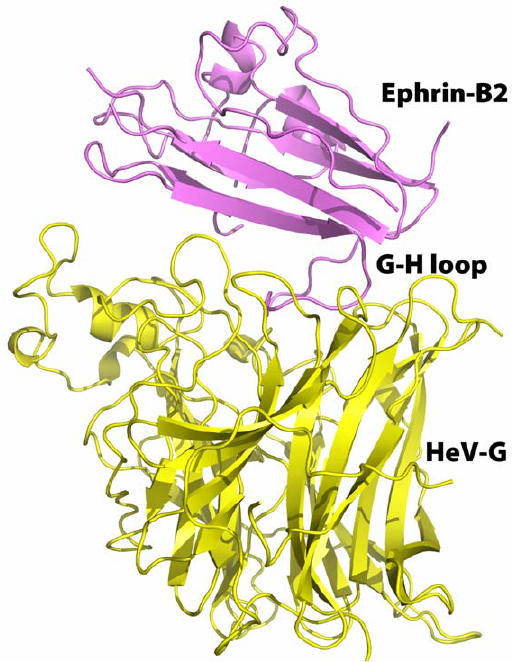
Figure 2. Structure of the HeV-G/ephrin-B2 complex. The HeV-G and ephrin-B2 molecule are colored in yellow and purple, respectively. Ephrin-B2 sits on top face of the HeV-G b -propeller. The G-H loop of ephrin-B2 extends into the central cavity of HeV-G’s b -propeller barrel.